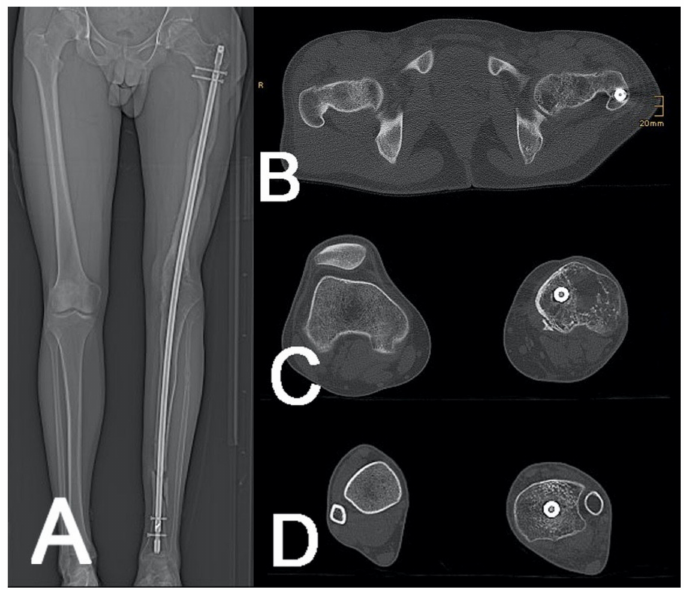
Figure 6. Rotational CT to plan the de-rotation surgery of a knee arthrodesis nail ( A ). Measurements of the hip ( B ), knee ( C ), and ankle joint ( D ) were performed.